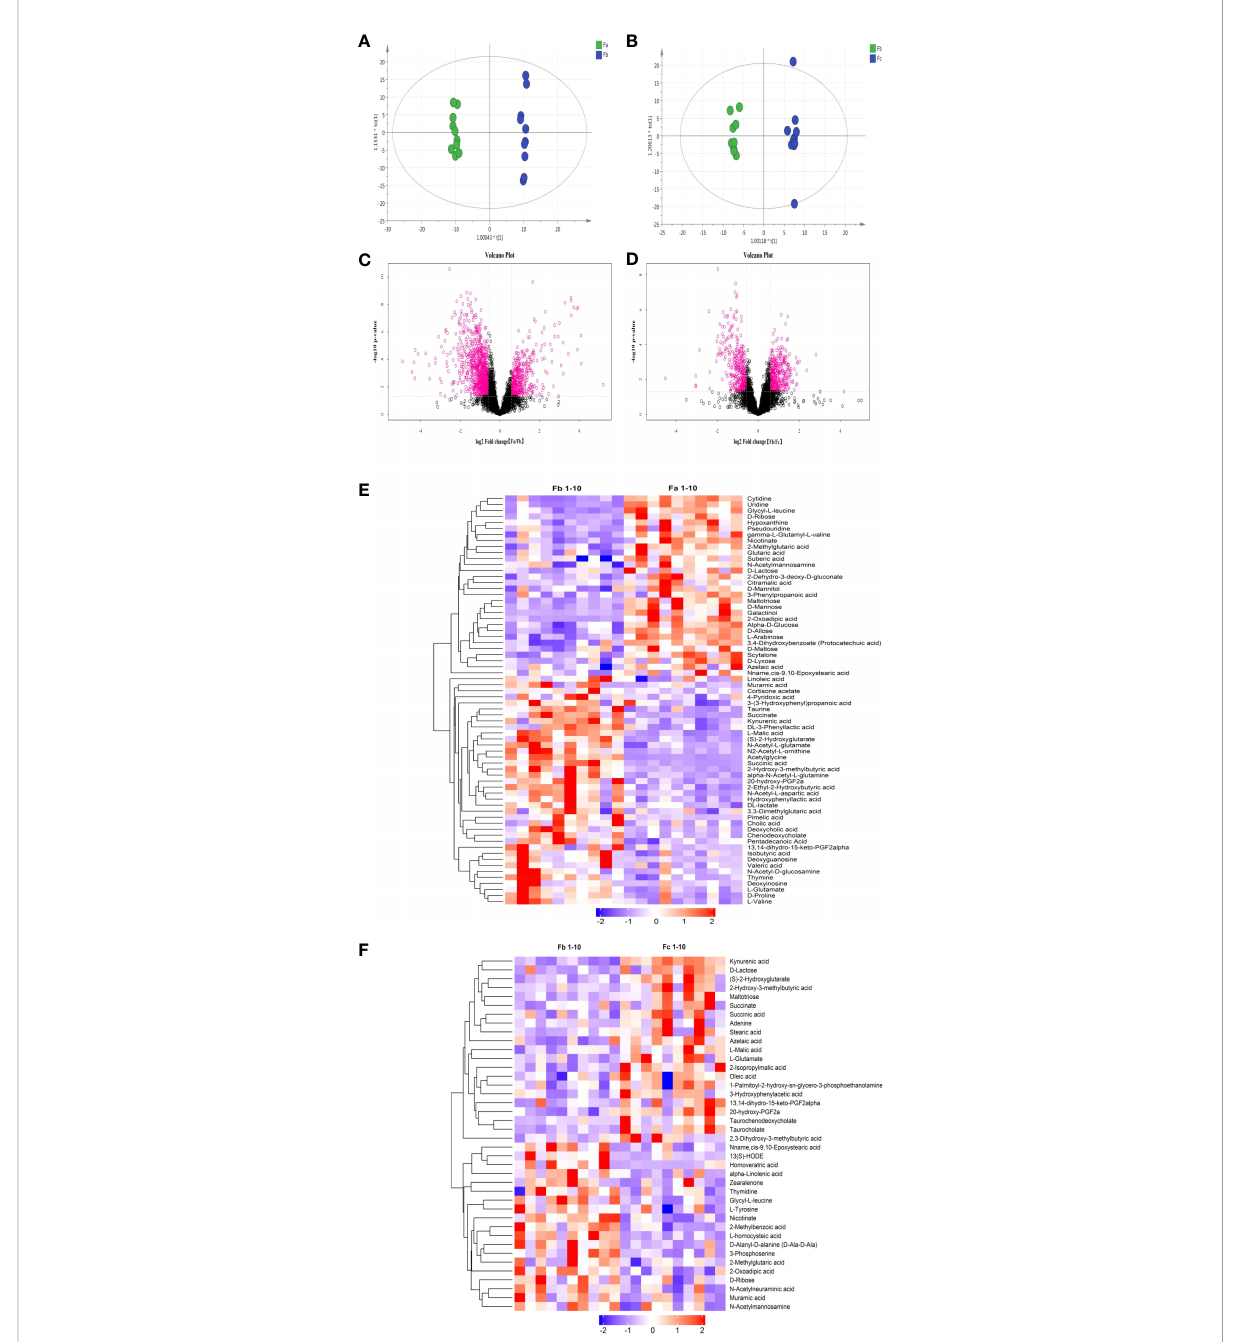
FIGURE 6 Results of untargeted metabolomics analysis. (A) , OPLS-DA analysis of fecal samples from the CUMS+FMT and CUMS groups before/after CUMS (Fa/Fb); (B) , OPLS-DA analysis of fecal samples from the CUMS+FMT group before/after FMT (Fb/Fc); (C, D) Volcano plot; (C) , Anion mode analysis of fecal samples from the CUMS+FMT group before/after CUMS (Fa/Fb); (D) , Anion mode analysis of fecal samples from the CUMS+FMT group before/after FMT(Fb/Fc). Red represents differentially expressed metabolites; (E) , Heat map analysis of fecal samples from CUMS+FMT group before/ after CUMS (Fa/Fb); (F) , Heat map analysis offecal samples from CUMS+FMT group before/after FMT (Fb/Fc); purple represents downregulation and red represents upregulation. OPLS-DA, Orthogonal Partial Least Square-Discriminate Analysis; Fa, fecal samples from the CUMS+FMT group before CUMS; Fb, fecal samples from the CUMS+FMT group after CUMS; Fc, fecal samples from the CUMS+FMT group after FMT; VIP, variable importance in projection; FC, fold change; CUMS, chronic unpredictable mild stress; FMT, fecal microbiota